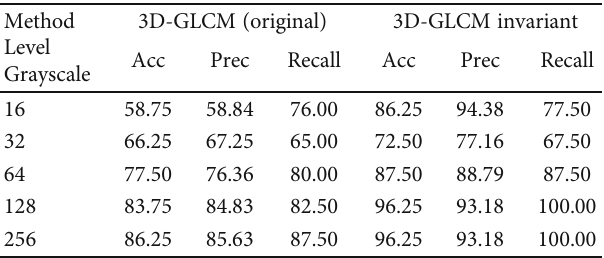
Table 6: Test results on the X-ray pneumonia